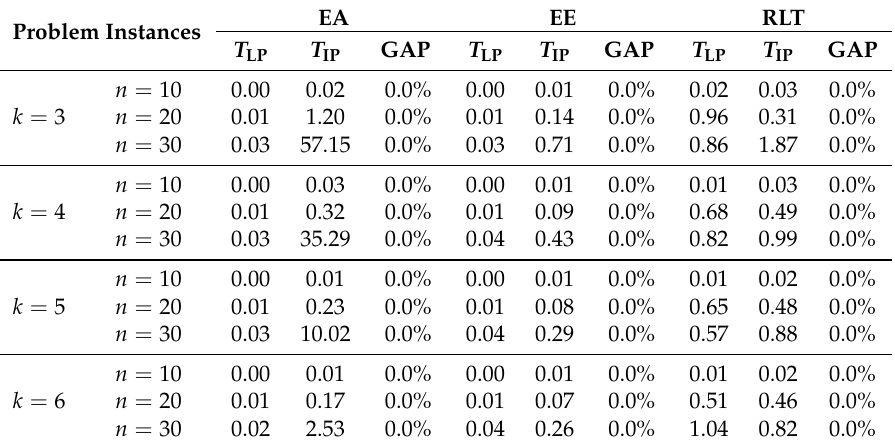
Table 3. Computational results for high-density